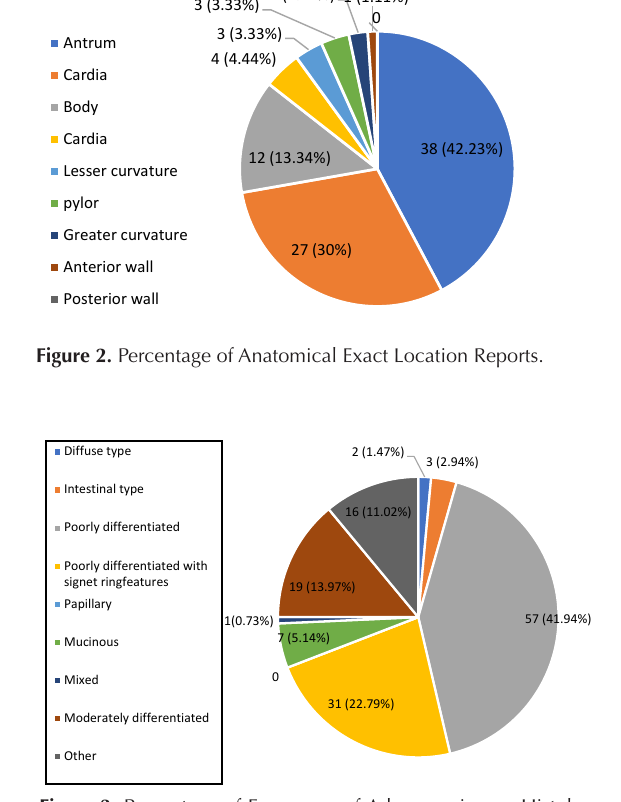
Figure 3. Percentage of Frequency of Adenocarcinoma Histology Type Report.